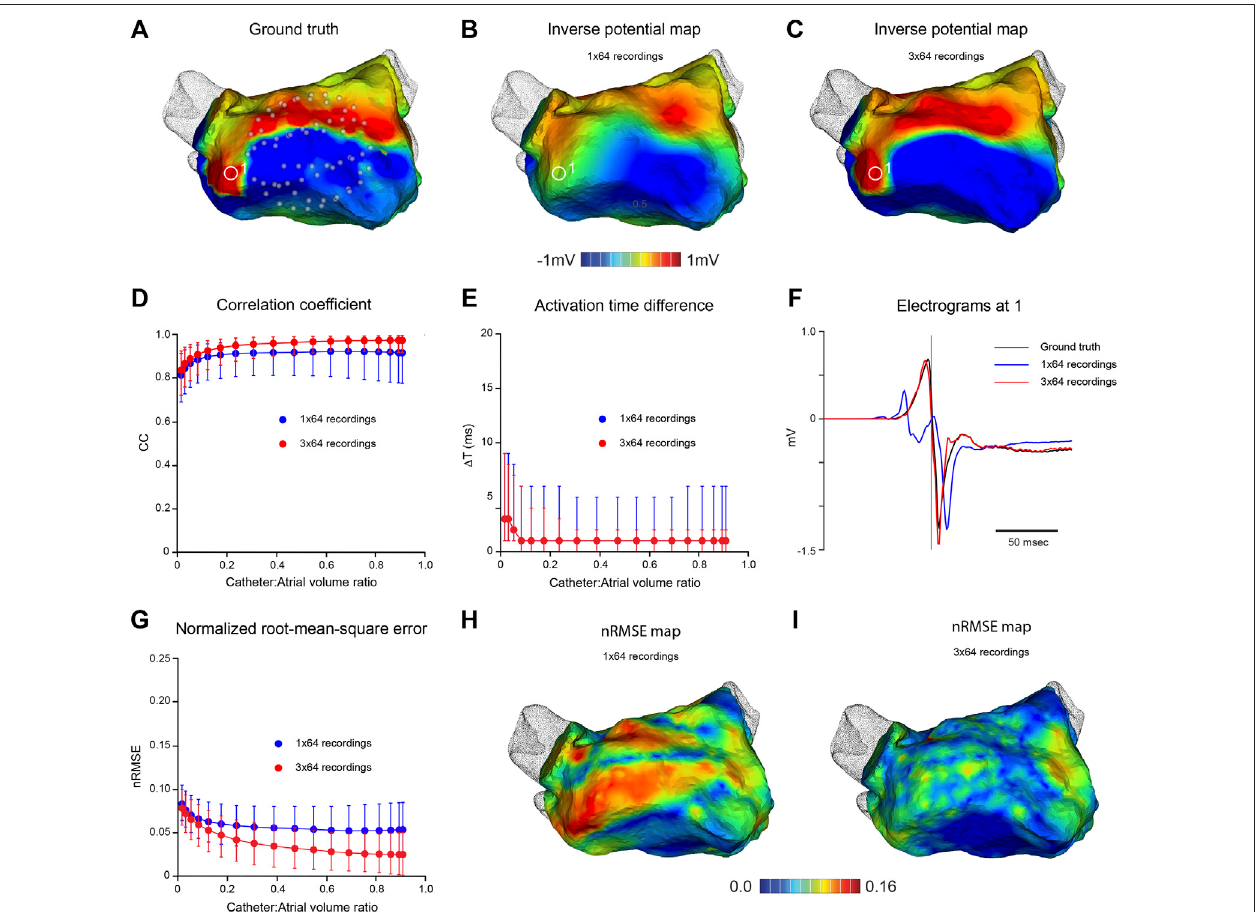
FIGURE 2 | In silico analysis of the effects of mapping catheter dimension and electrode distribution on MFS inverse solutions during pacing from distal coronary sinus. Ground-truth LA surface potential distributions during atrial activation are constructed from pace-synchronized contact recordings acquired with a high density electrode array. Corresponding potential fi elds in the LA cavity are estimated throughout the atrial activation cycle and “ sampled ” at locations of virtual basket catheter electrodes. Inverse surface potential maps are then reconstructed from these data and compared with ground truth maps. (A) Ground-truth LA surface potential distributionat oneinstantduring activation-see redlinein (C) .Correspondinginverse potential map (B) reconstructedfrompotentialssampledwithvirtual 64-electrode basket catheter with 0.67 volume fraction relative to LA. Electrodes are distributed uniformly along 8 splines as indicated in (A) . (C) Ground truth and reconstructed electrograms at 1 in (A,B) . In the middle panel, CC (D) , nRMSE (E) and Δ T (F) are presented as functions of relative catheter volume for inverse solutions over one activation cycle. Median values and IQR are given for inverse maps constructed from “ recordings ” at 64 sites (blue) and 3 sequential “ recordings ” at 64 sites following stepwiserotationofthecatheterthrough15 ° arounditsaxis(red).Bothmapsinthelowerpanelrelatetothesametimeasin (A,B) .In (G) ,thedistributionofnRMSEonthe LAsurfaceiscomparedwithsplinelocationforapotentialmapconstructedfrom64fullornear-contact “ recordings ” ,while (H) correspondsto (B) .Here,theinversemap was constructed from 3 sequential “ recordings ” at 64 sites with a relative catheter volume fraction of 0.67. (I) Ground truth and inverse electrograms at 2) in (H) . Abbreviations: MFS, Method of Fundamental Solutions; LA, left atrium; CC, correlation coef fi cient; nRMSE, normalized root-mean-squared error; Δ T, activation time difference; IQR, interquartile